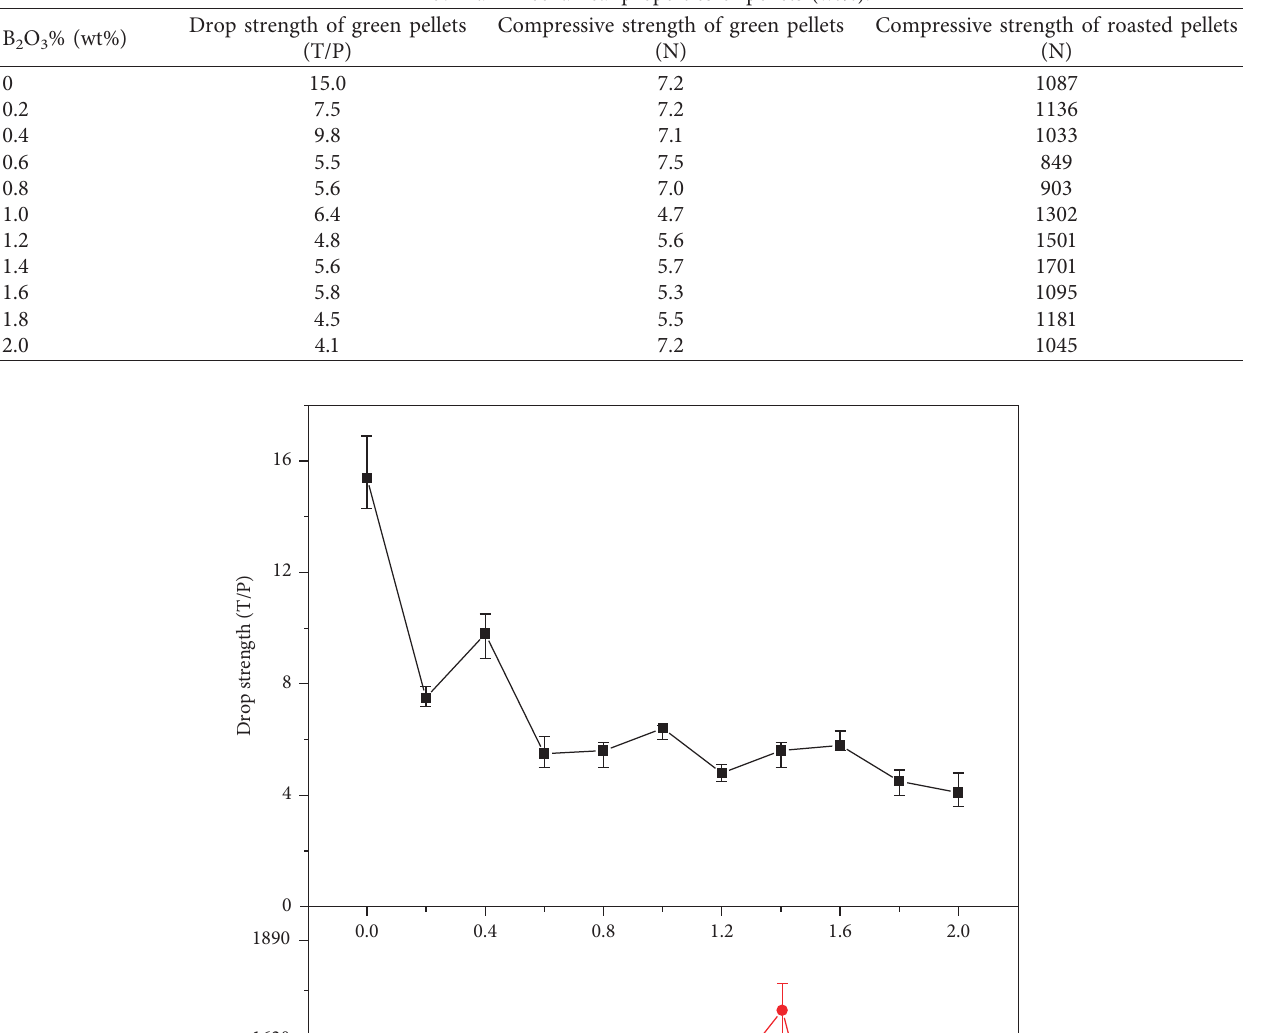
Table 3: Main mechanical properties of pellets (wt%).